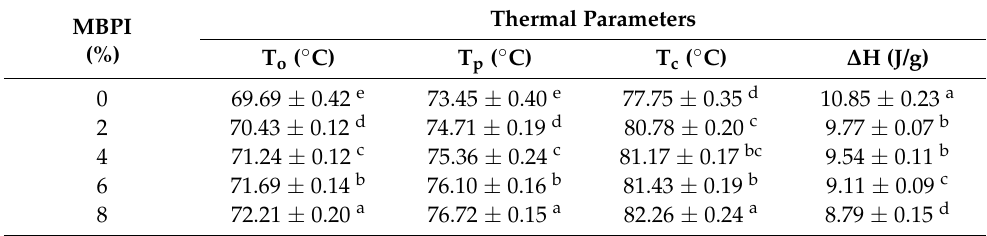
Table 2. Thermal properties of NCS and NCS/MBPI gels at different MBPI